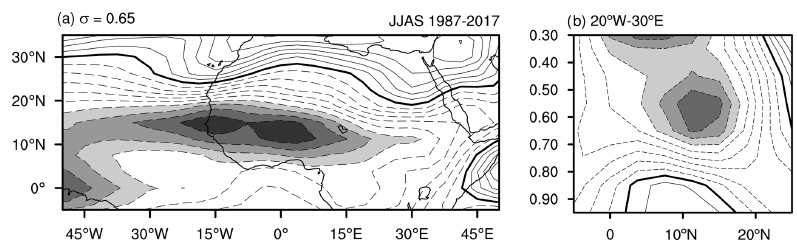
Figure 3. JJAS 1987–2017 averaged climatological zonal winds ( U < − 6ms − 1 shaded and negative values dashed) for (a) σ = 0 . 65 level and (b) latitude–height cross section averaged over 15 ◦ W–15 ◦ E.